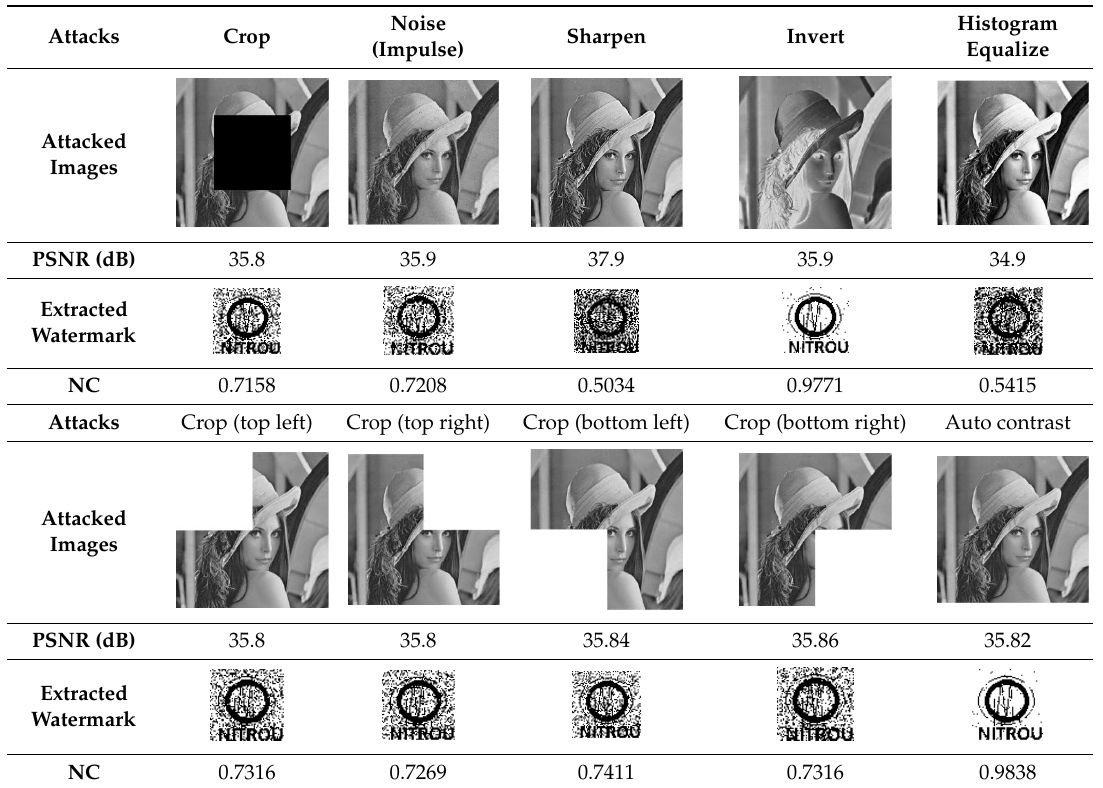
Table 4. Simulation results of common image processing attacks.